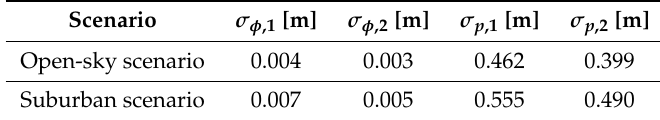
Table 3. Between-receiver phase ( σ φ , j ) and code ( σ p , j ) standard deviations at the zenith direction and with the C/N 0 of ∞